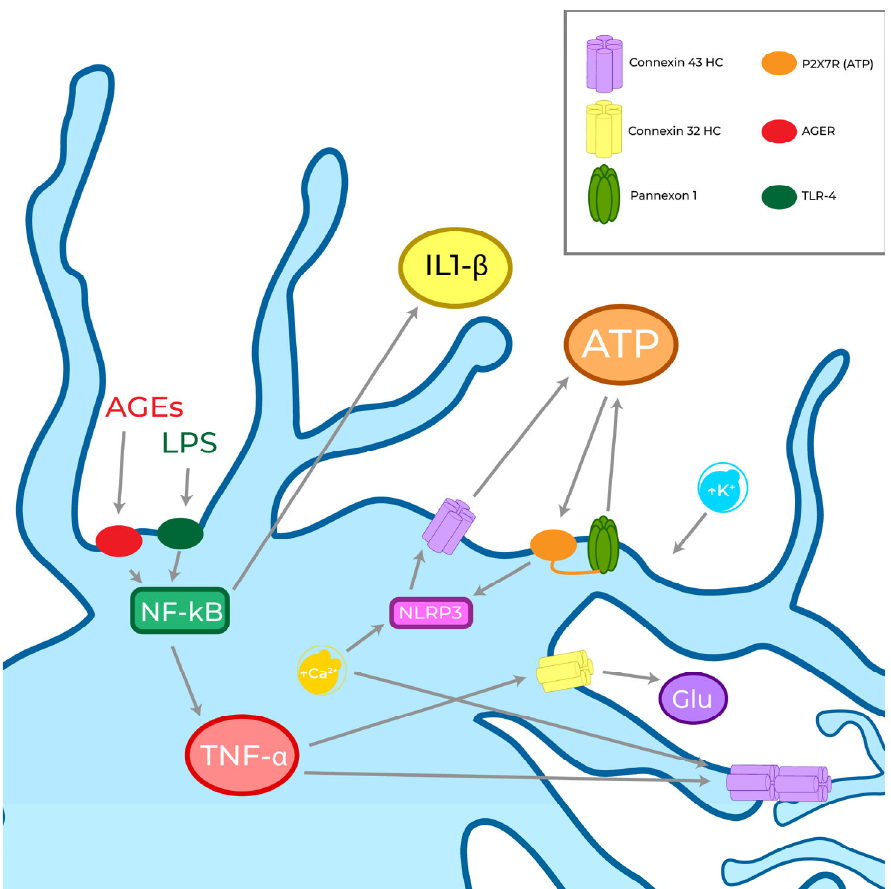
Figure 4. Cxs are fundamental in microglial communication, specifically because of their ability to secrete ATP and glutamate, known to be messengers of danger in the extracellular environment. Their gating is highly regulated by the inflammation pathway (NF- κ B) through the release of TNF- α . ATP acts as an autocrine messenger and sustains its own release by activating NLRP3 pathway. It worth noting that a physical interaction between P2X7R and Panx1 has been observed.